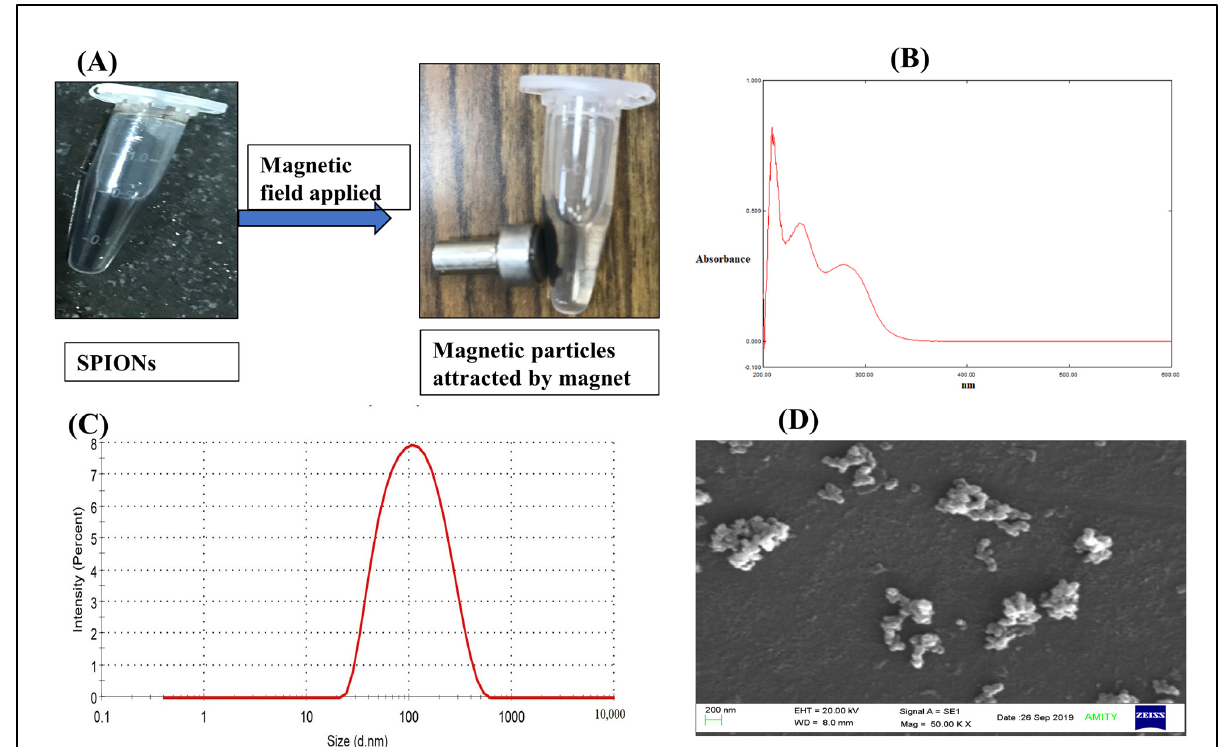
Figure 1. Characterizations of green synthesized SPIONs. ( A ) Green synthesized SPIONS using (-) EGCG showed magnetic properties in the presence of an externally applied magnetic field. ( B ) UV- visible absorption spectra of SPIONs in the UV-visible range (200–600 nm) showed maximum ab- sorption (characteristic) peaks at 210, 236, and 278.5 nm. ( C ) Particle size distribution (hydrodynamic diameter) profile of SPIONs. ( D ) SEM image of SPIONs (scale bar 200 nm).